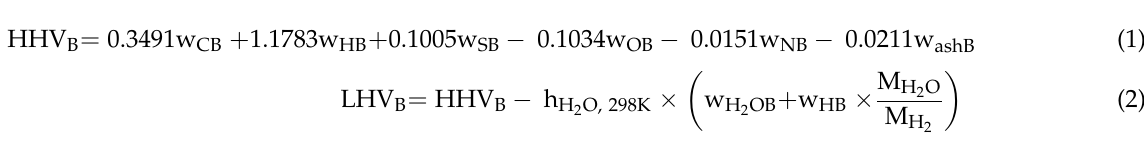
Table 2. Chemical characterization of the RFB from eucalyptus.